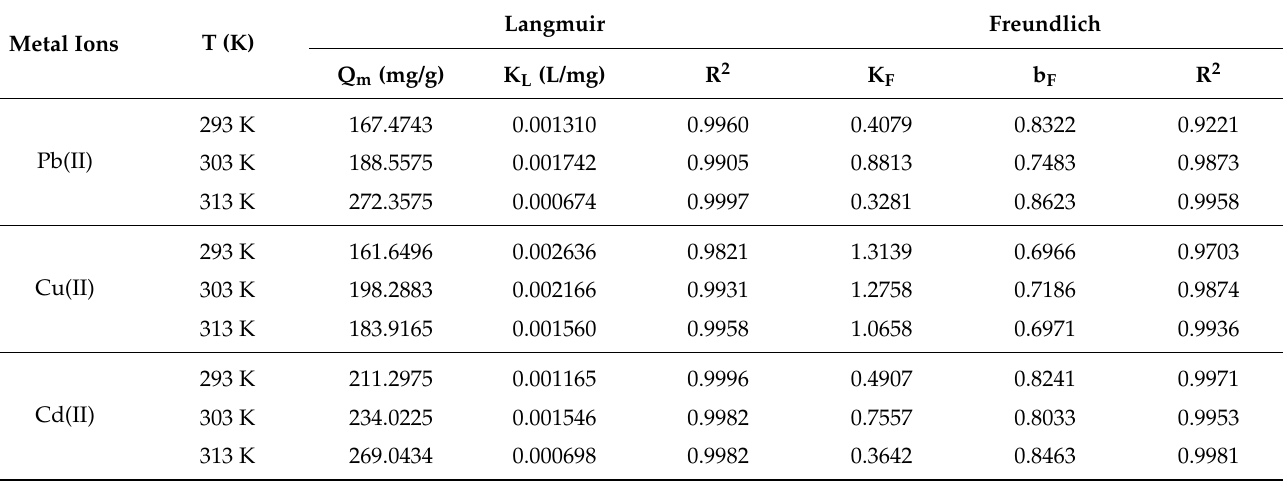
Figure 6. Effect of temperature on the adsorption of Pb(II) ( a ), Cu(II) ( b ), and Cd(II) ( c ) (pH = 5.5). Table 3. Adsorption kinetics results for metal ions on the